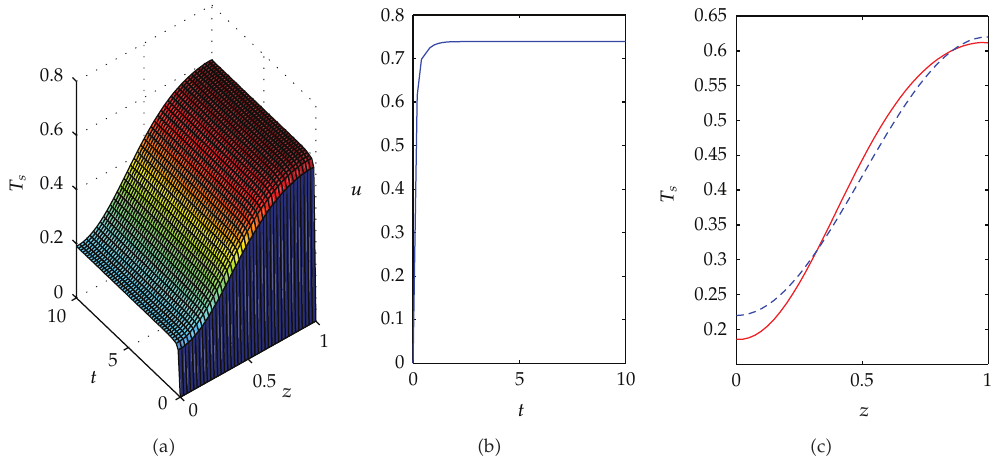
Figure 8: Controlled by a clustering and SVM-regression learning-based 3-D FLC under disturbed situation (cid:3) dotted line: reference profile (cid:4)